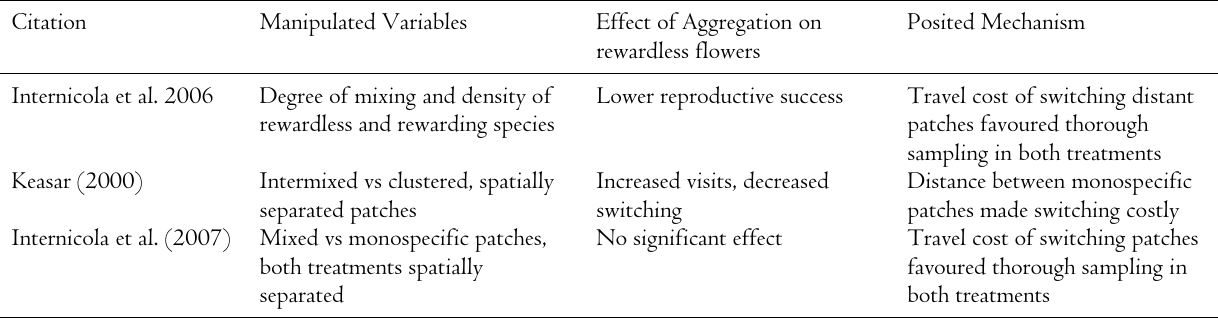
Table 1. Summary of previous studies exploring effects of dispersion of rewarding and rewardless flowers on aspects of the re wardless